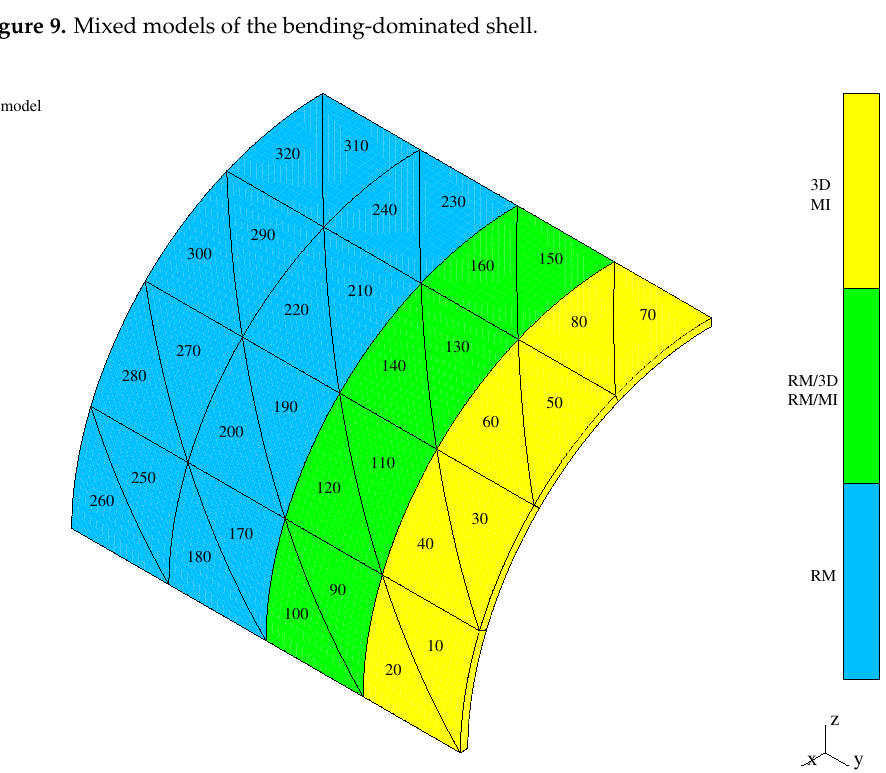
Figure 10. Mixed models of the membrane-dominated